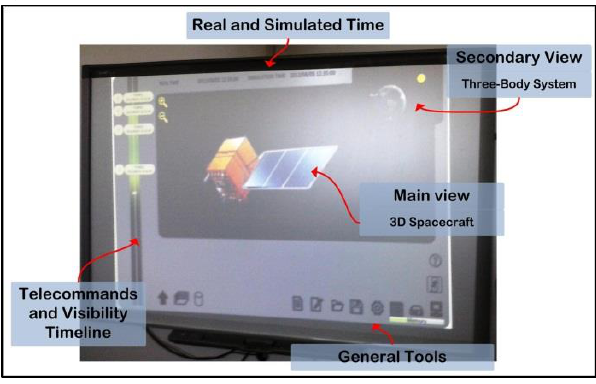
Fig. 20. Main screen first release with CBERS satellite in the background.